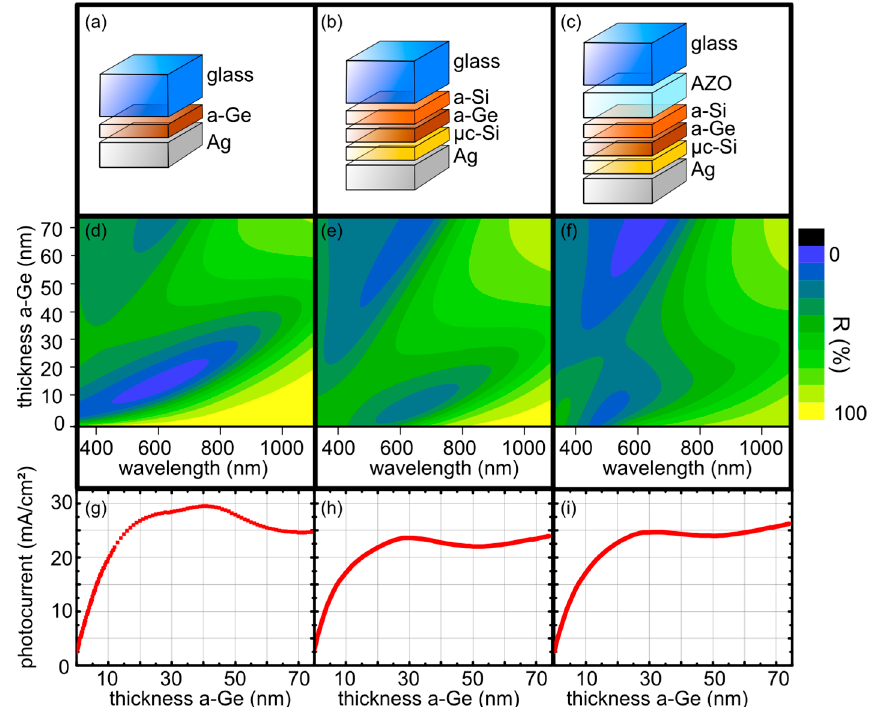
Figure 3. Influence of absorber thickness and surrounding materials on reflectance and absorption: layer stacks ( a – c ), reflection spectra ( d – f ), and photocurrent generated in the a-Ge:H absorber layer ( g – i